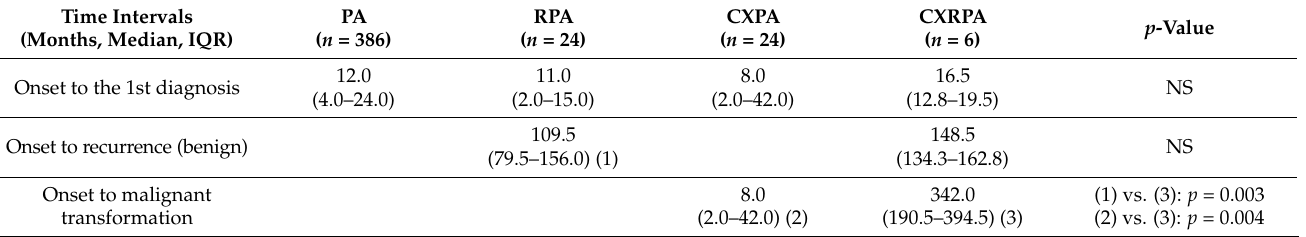
Table 3. Time–event sequences of recurrence and malignant transformation in pleomorphic